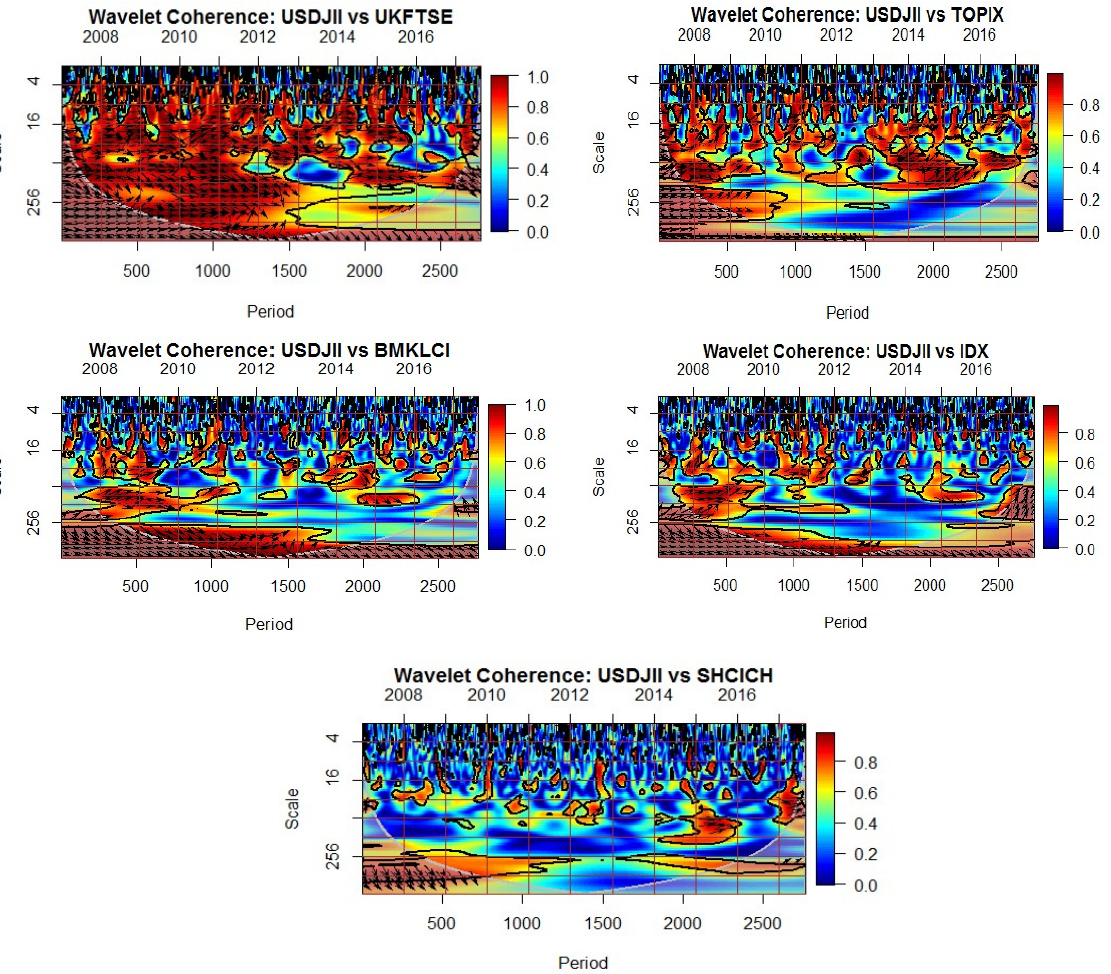
Figure 4. WCT: USDJII vs. UKFTSE; USDJII vs. TOPIX; USDJII vs. BMKLCI; USDJII vs. IDX; USDJII vs. SHCICH.